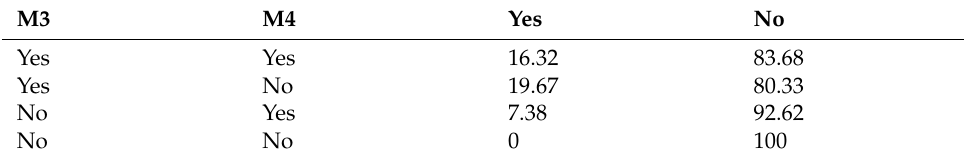
Table A9. Conditional probability of node M6.